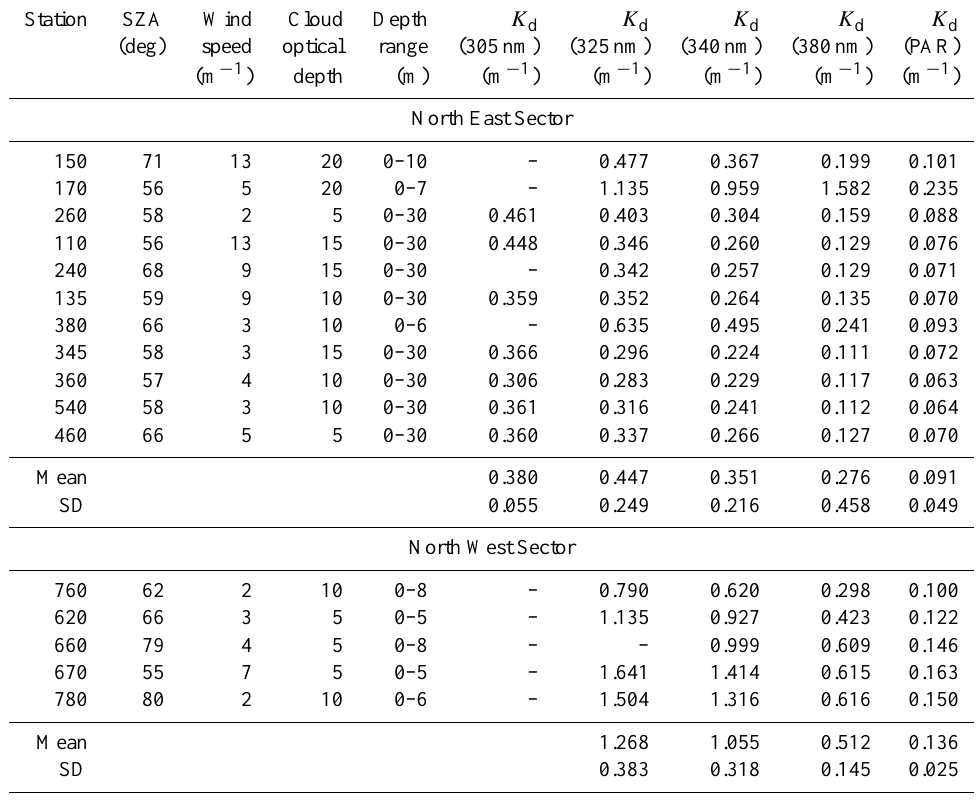
Table 2. Values of diffuse attenuation coefficient of light in the UV-B (305 nm), UV-A (325, 340 and 380nm) and PAR spectral domains determined in surface waters of each sampling stations and among the different sectors. Environmental conditions, including solar zenith angle (SZA), wind speed, and cloud optical depth estimation are also reported, as well as the maximal depth range from which surface K d (λ) values were derived.